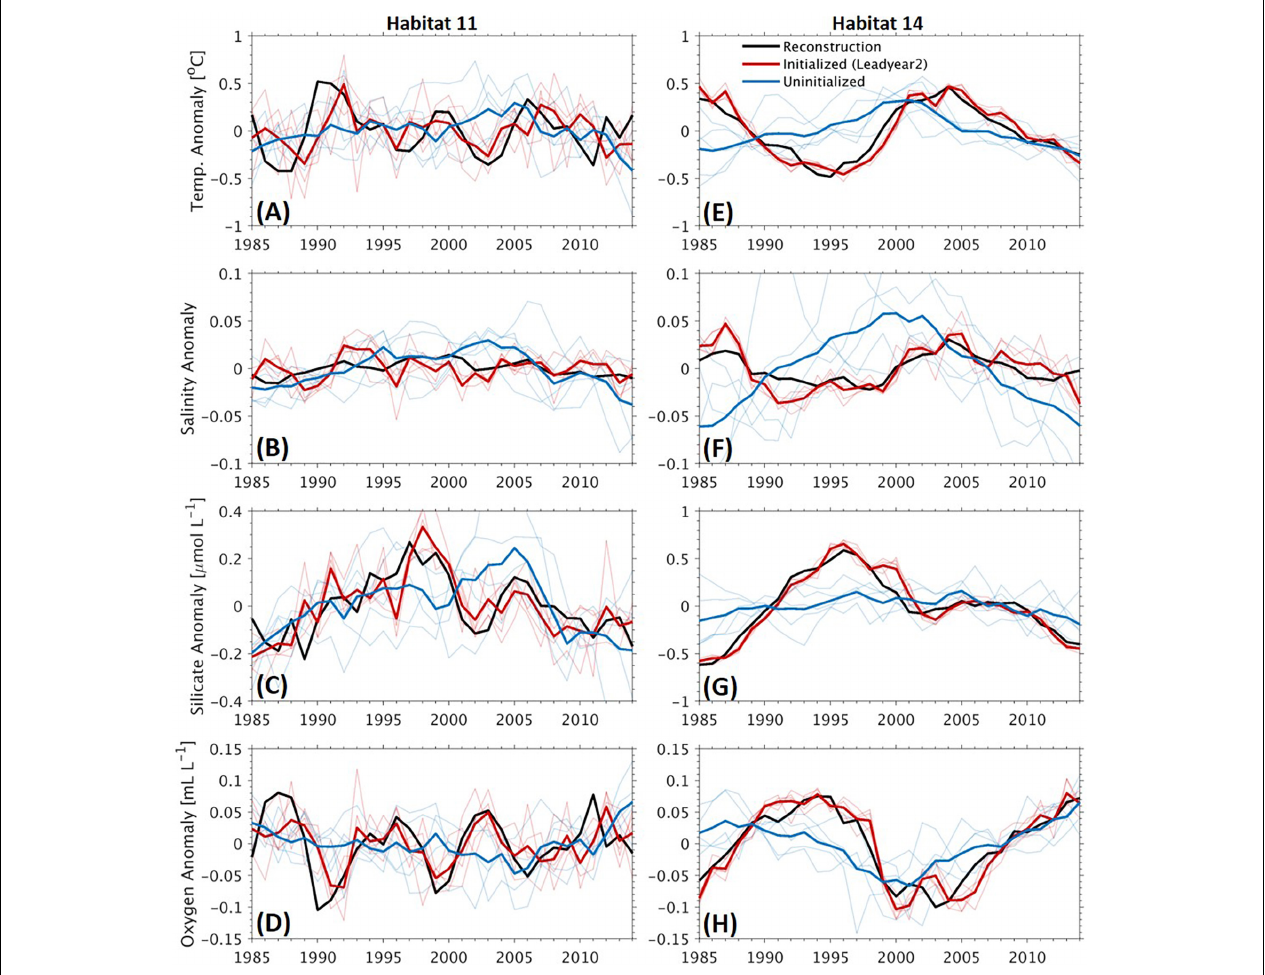
FIGURE 6 | Time series of detrended anomalies of annual mean temperature (A,E) , salinity (B,F) , concentrations of silicate (C,G) , and oxygen (D,H) at sponge habitats 11 (A–D) and 14 (E–H) . Bold black lines: reconstruction, bold red/blue lines: ensemble means of the initialized/uninitialized simulations at a lead time of 2 years, thin red/blue lines: individual members of the initialized/uninitialized simulations. The locations of the two habitats can be seen in Figure 1